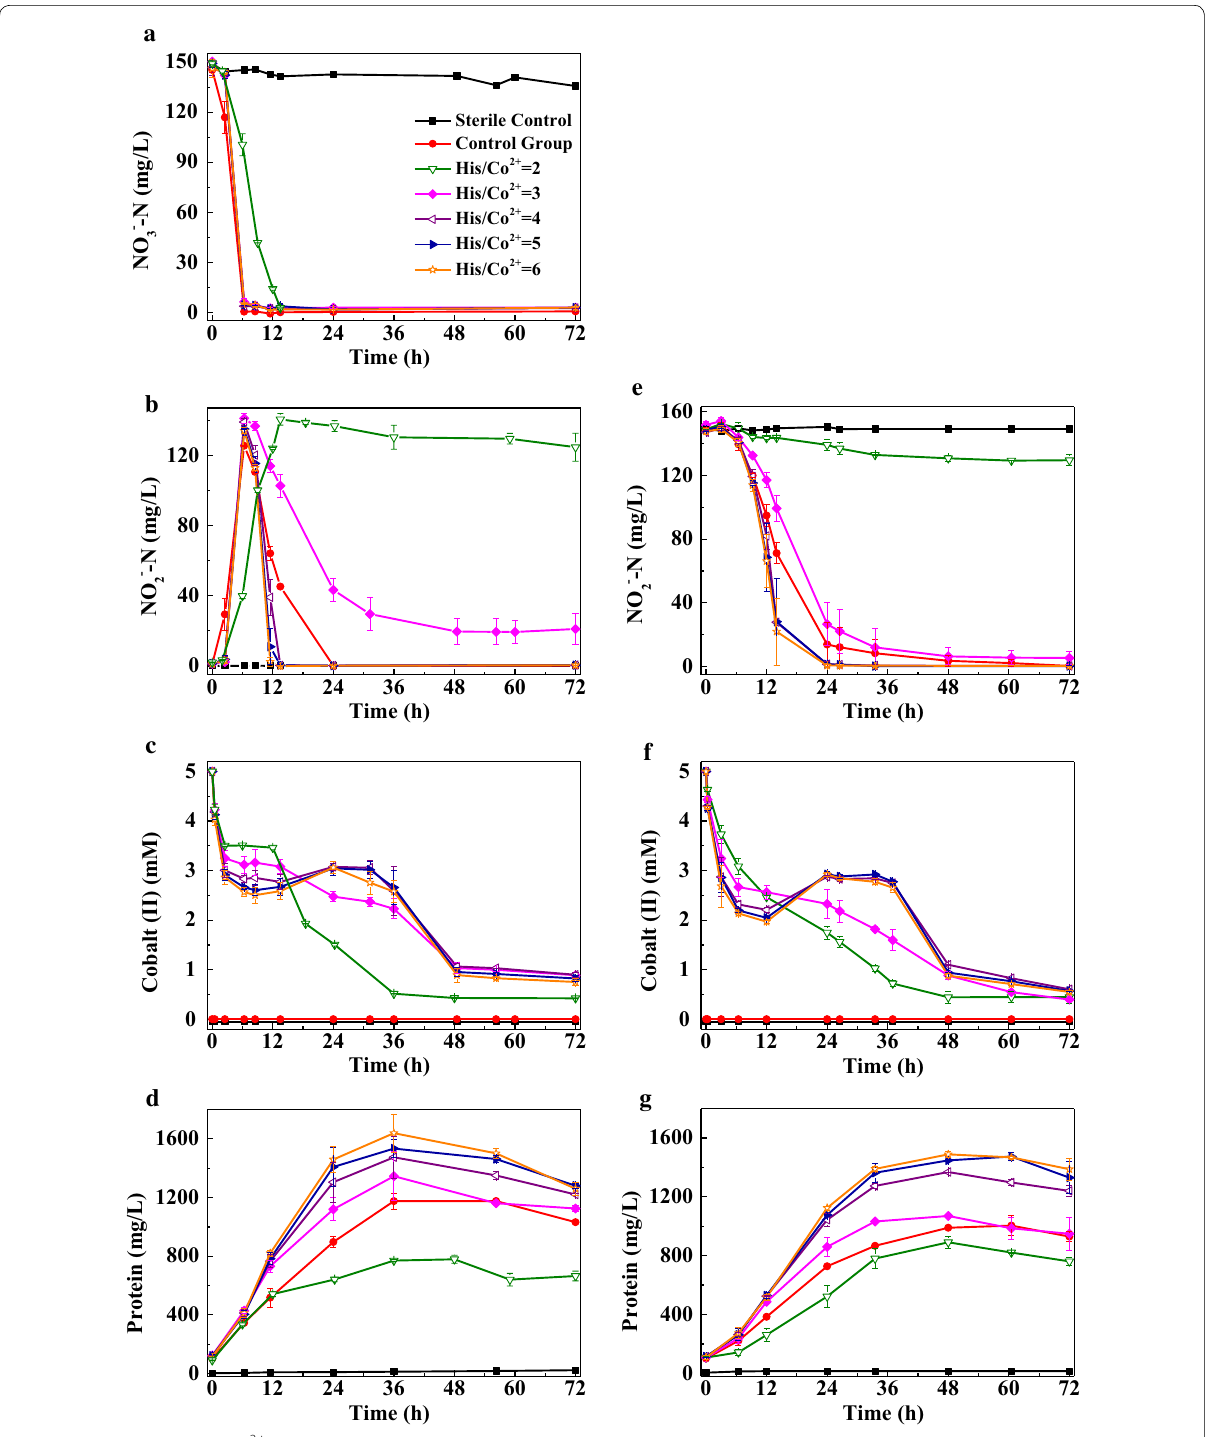
Fig. 2 Effects of initial His/Co 2 + on the removal of nitrate ( a – d ) and nitrite ( e – g ) under aerobic atmosphere by strain